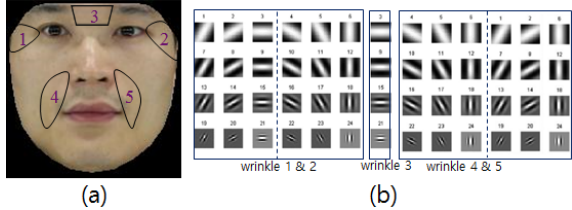
Figure 10. Wrinkle set and Gabor filter set: ( a ) Wrinkle set. ( b ) Gabor filters for wrinkle set [37].